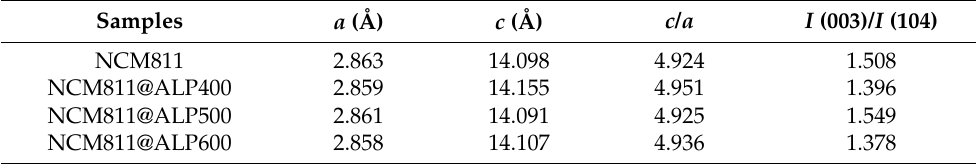
Table 1. Lattice parameters of bare and Al(PO 3 ) 3 -coated LiNi 0.8 Co 0.1 Mn 0.1 O 2